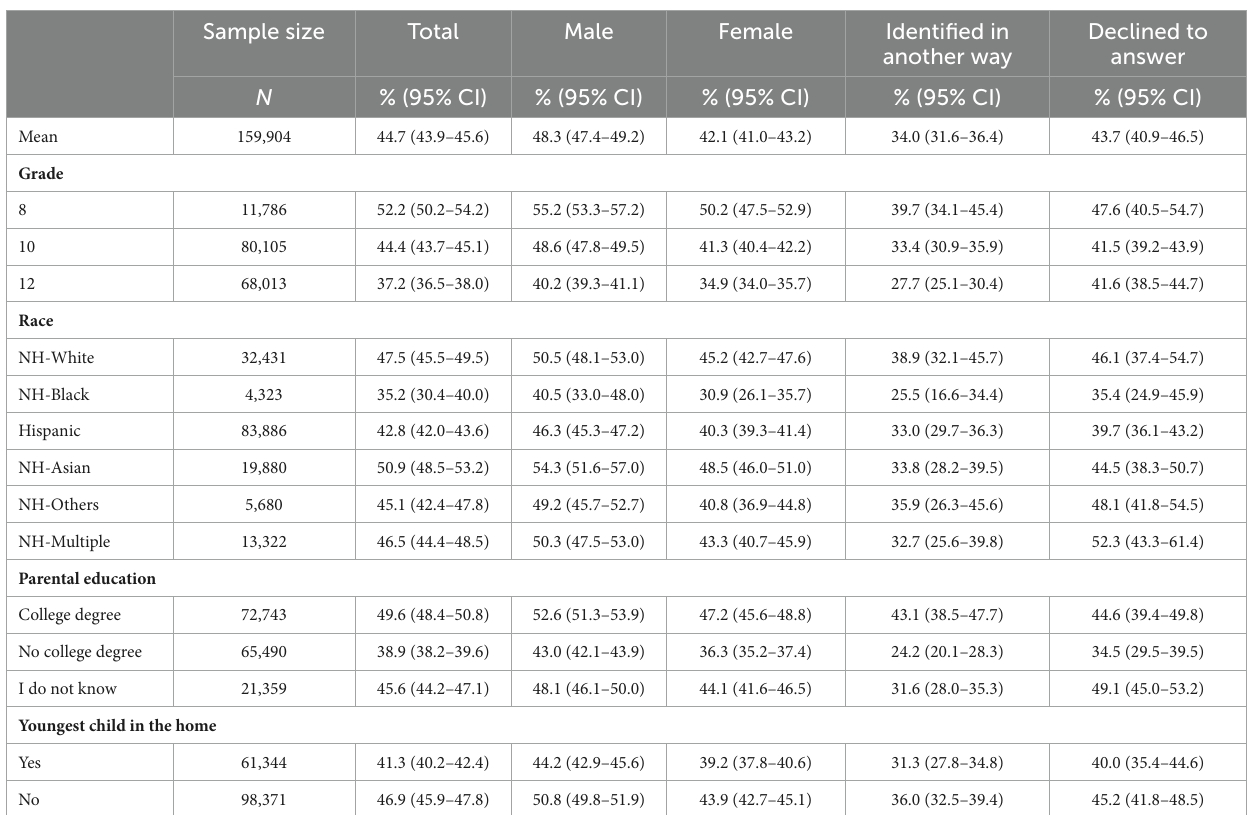
TABLE 1 Percentage of middle and high school students having frequent family meals, by gender. Sample size Total